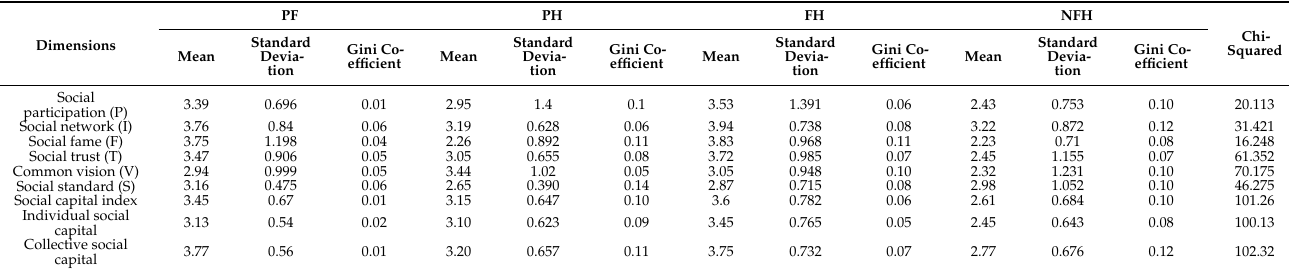
Figure 5. Status quo of subjective well-being of farmers and herdsmen. (2) Social capital features of farmers and herdsmen under four production modes A chi-squared test for multiple samples was carried out on the social capital of farmers and herdsmen under four production modes. The chi-squared values of the different dimensional indicators for social capital were 20.113, 31.421, 16.248, 61.352, 70.175, 46.273, and 101.25, and the corresponding p -value was 0.000, below the significance level of 0.001. The results confirmed that farmers and herdsmen under different production modes differ significantly in social capital (Table 4). Table 4. Social capital features of farmers and herdsmen.